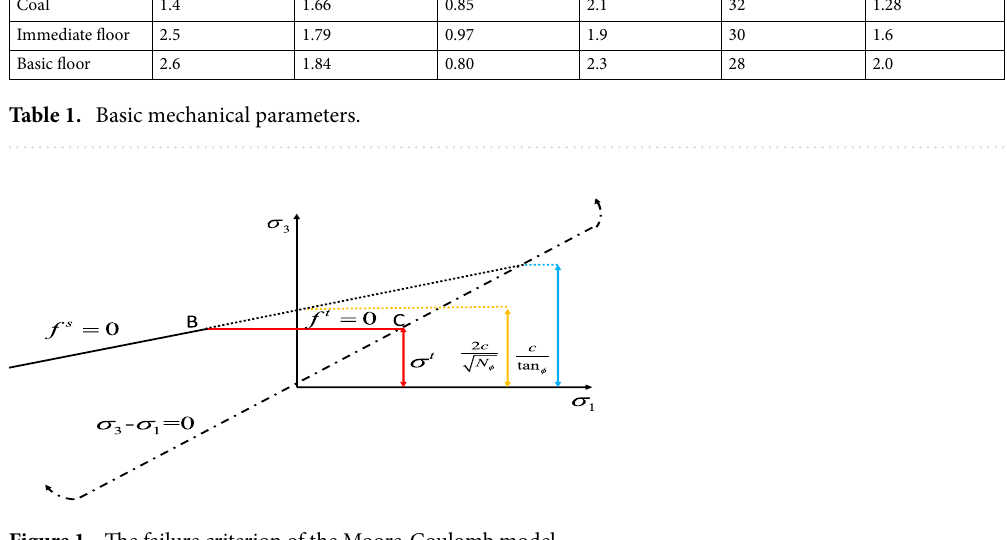
Figure 1. The failure criterion of the Moore-Coulomb